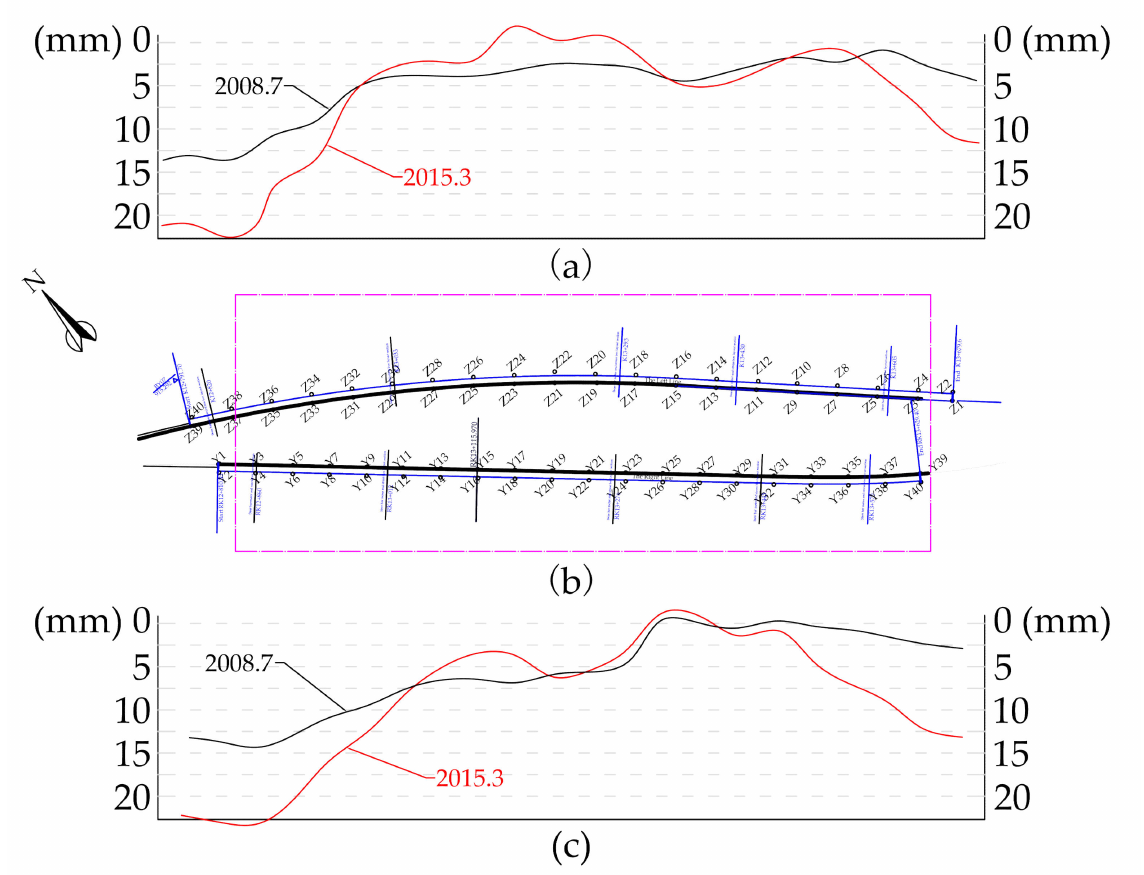
Figure 10. Subsidence of the side wall of the tunnel. ( a ) Subsidence of the left line side wall. ( b ) Layout of subsidence markers at the side walls. ( c ) Subsidence of the right line side wall.